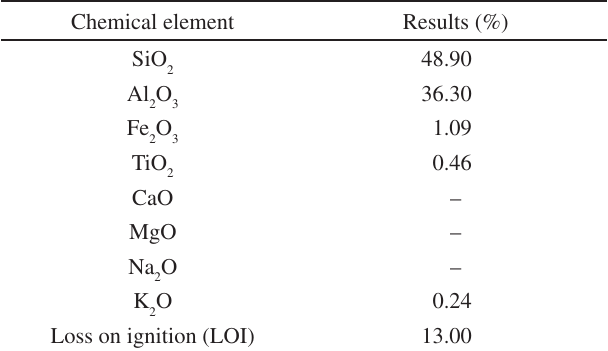
Table 1. Chemical analysis of São Simão clay.